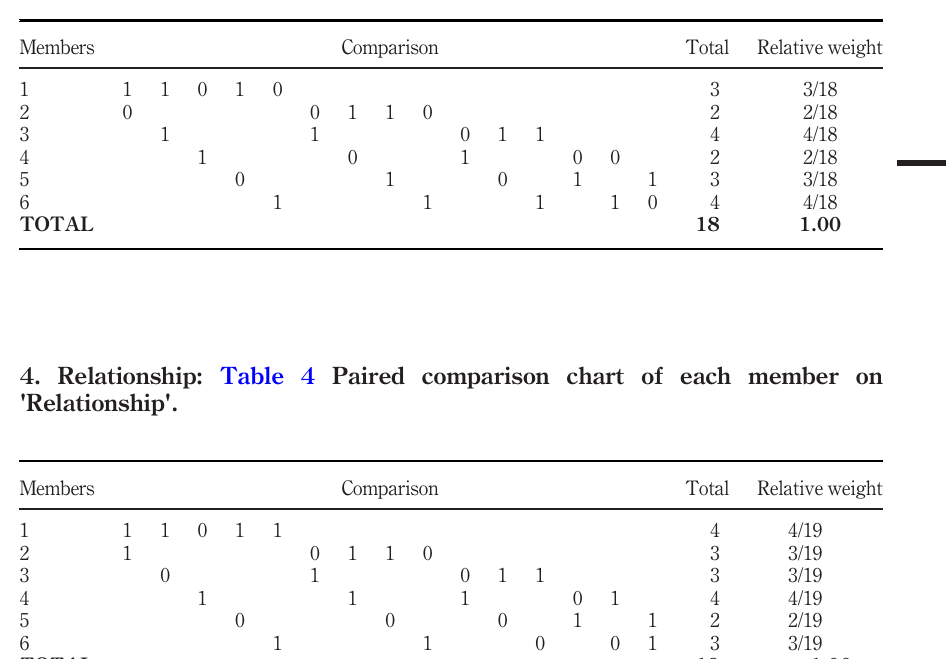
3. Commitment: Table 3 Paired comparison chart of each member on ‘ Commitment ’ .